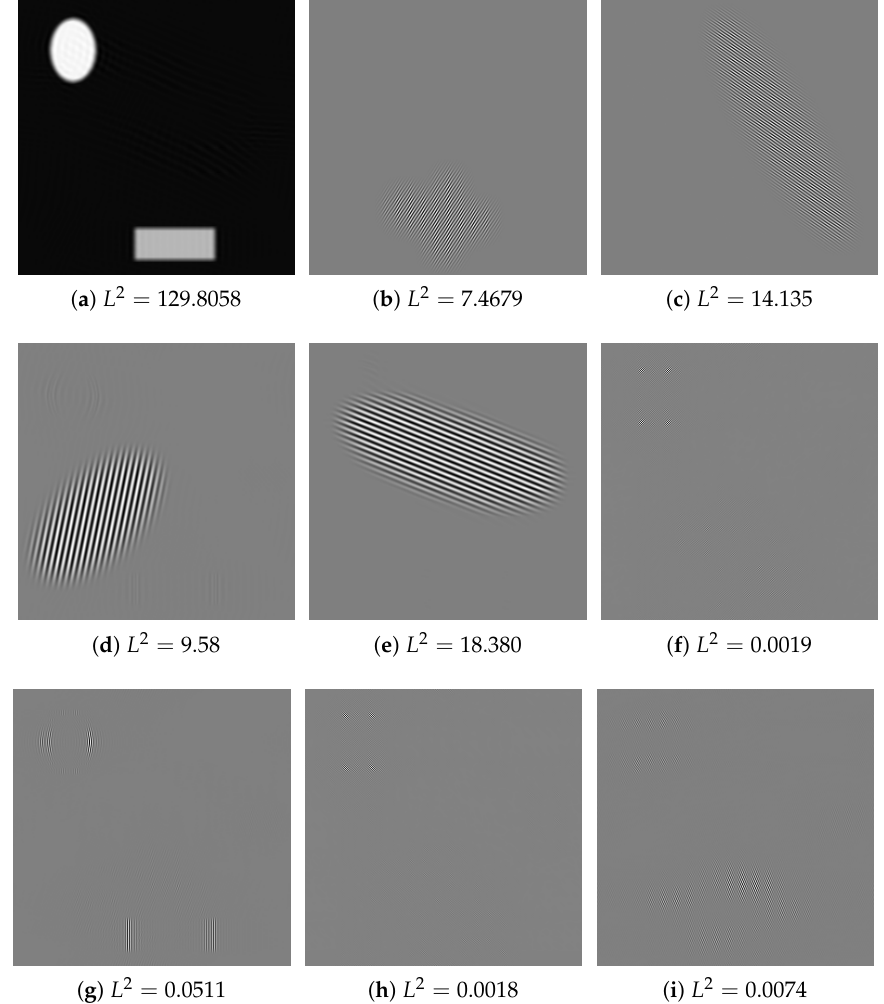
Figure 7. Empirical watershed wavelet coefficients for the image shown in Figure 6a with